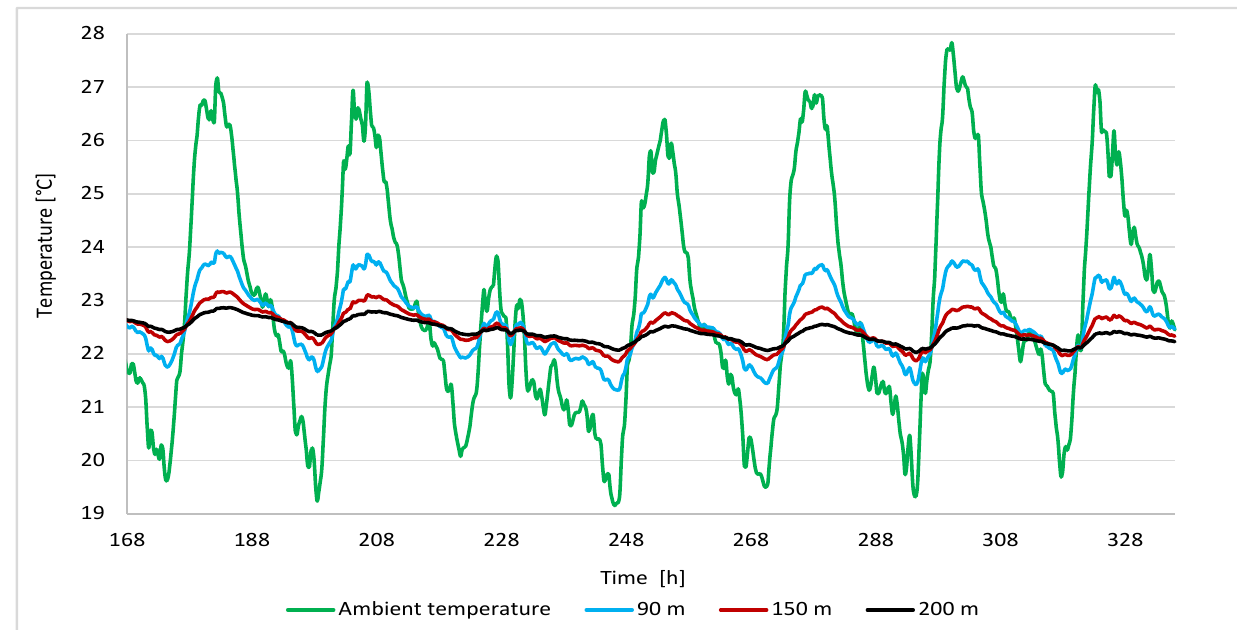
Figure 12. EAHE outlet air temperature vs pipe length.